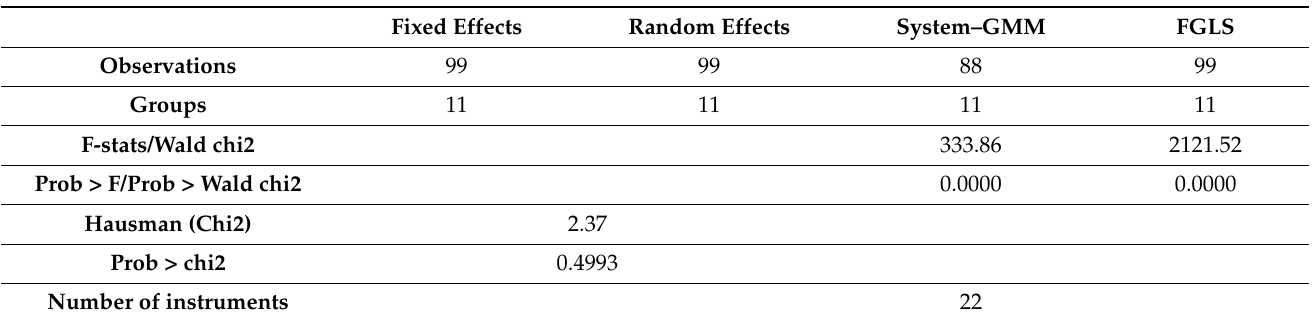
Table A1. Diagnostic tests of the data estimations on the impact of ICT adoption on stock market traded